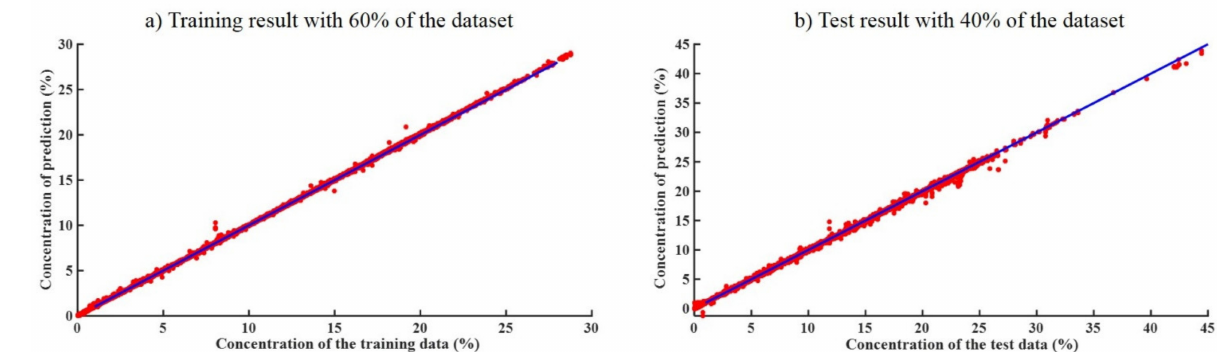
Figure 8. The learning results of 6:4 proportion.